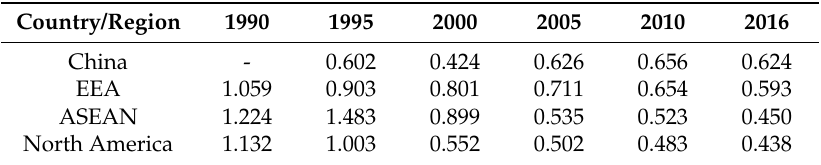
Source: global value chain data base, 2017.